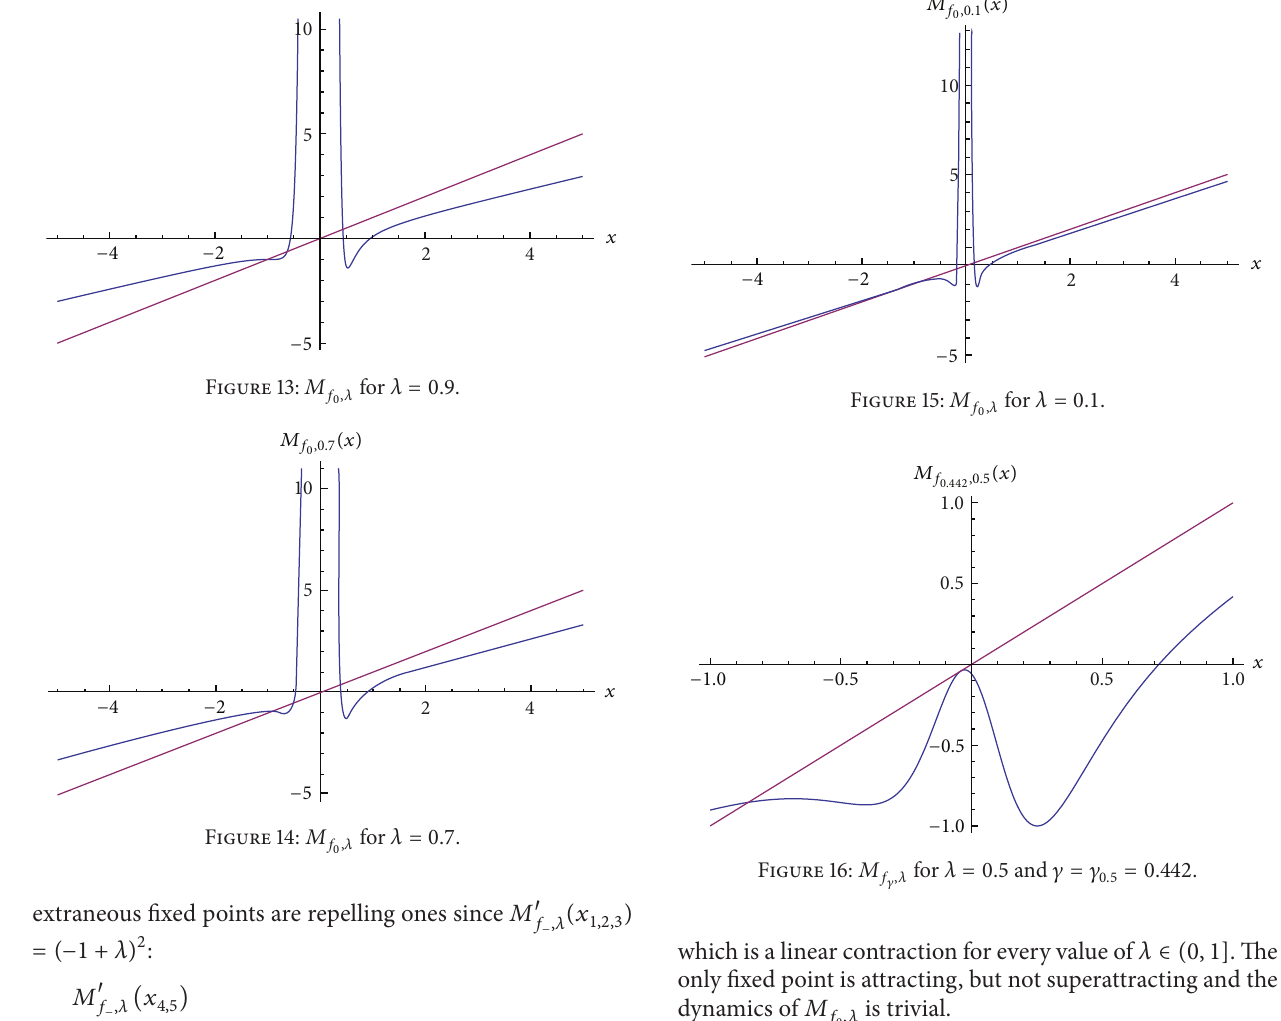
for 𝜆 = 0.5 and 𝛾 = 𝛾 0.5 = 0.442 . 𝛾 ,𝜆